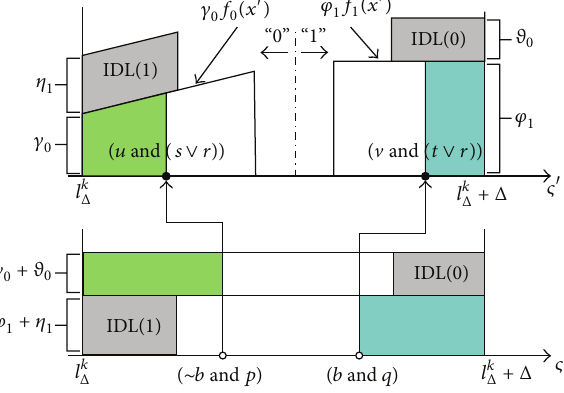
Figure 1: Illustration of the process of separation.